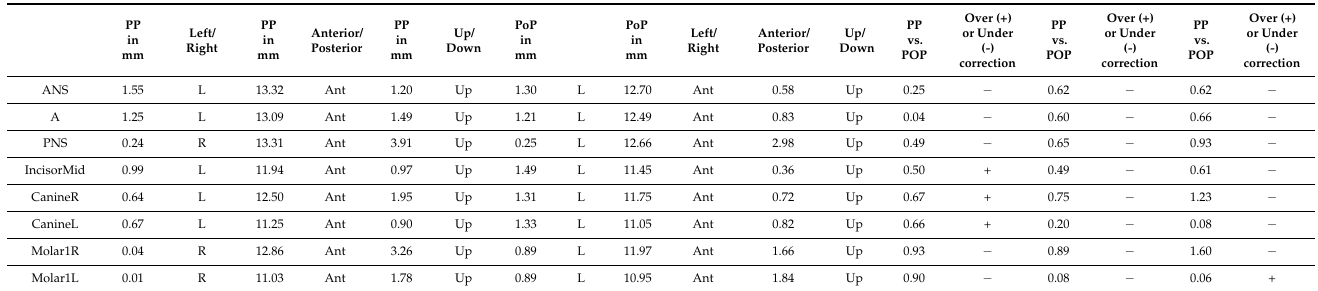
Figure 12. Overlay of the planned maxillary and mandibular position (green) with the postoperative position (orange). ( a ) View from the right ( b ). View from the left ( c ). View of the maxilla ( d ). View from palatal to the maxilla. Table 1. Differences and movements in X, Y and Z axis post-operative (POP) of the maxilla compared to the pre-operative planning (PP) in